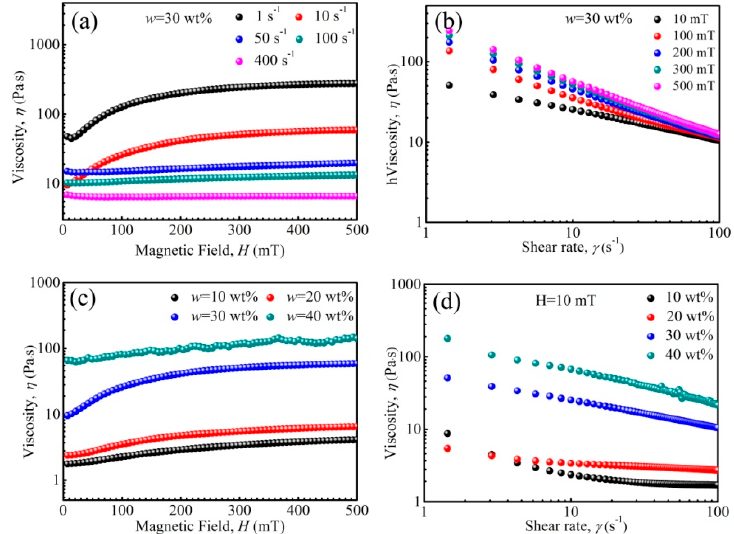
Figure 7. The viscosity of ferrofluids as a function of magnetic field ( a , c ), and shear rate ( b , d